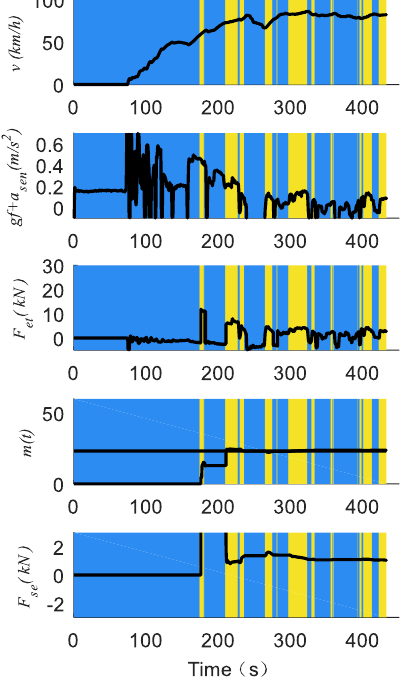
Figure 5. One set of the empty trailer test.